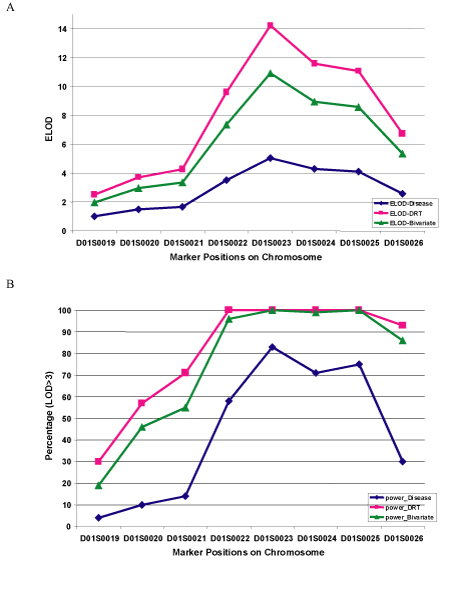
Linkage analysis of disease, DRT, and bivariate trait with the three cities dataset: ELOD (A) and power (percentage (LOD>3)) (B).